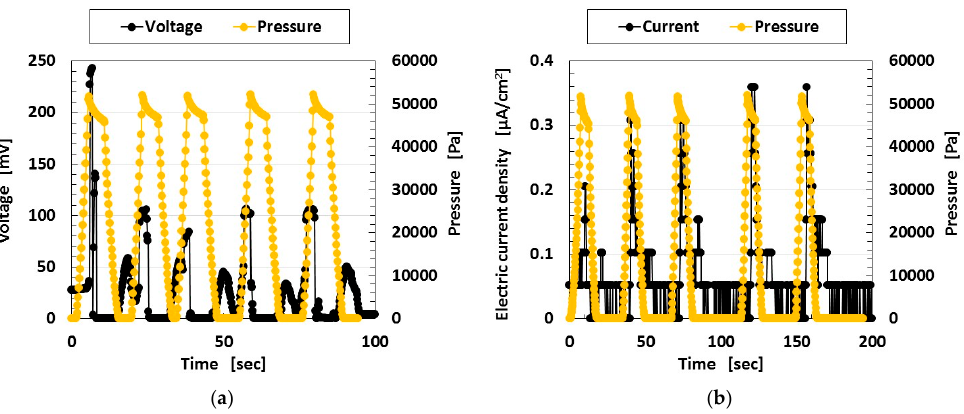
Figure 15. Changes in the voltage and electric current density with pressure repeated five times under ultraviolet irradiation: ( a ) voltage; ( b ) electric current density for wet-type MCF rubber solar cell electrolytically polymerized under a magnetic field.